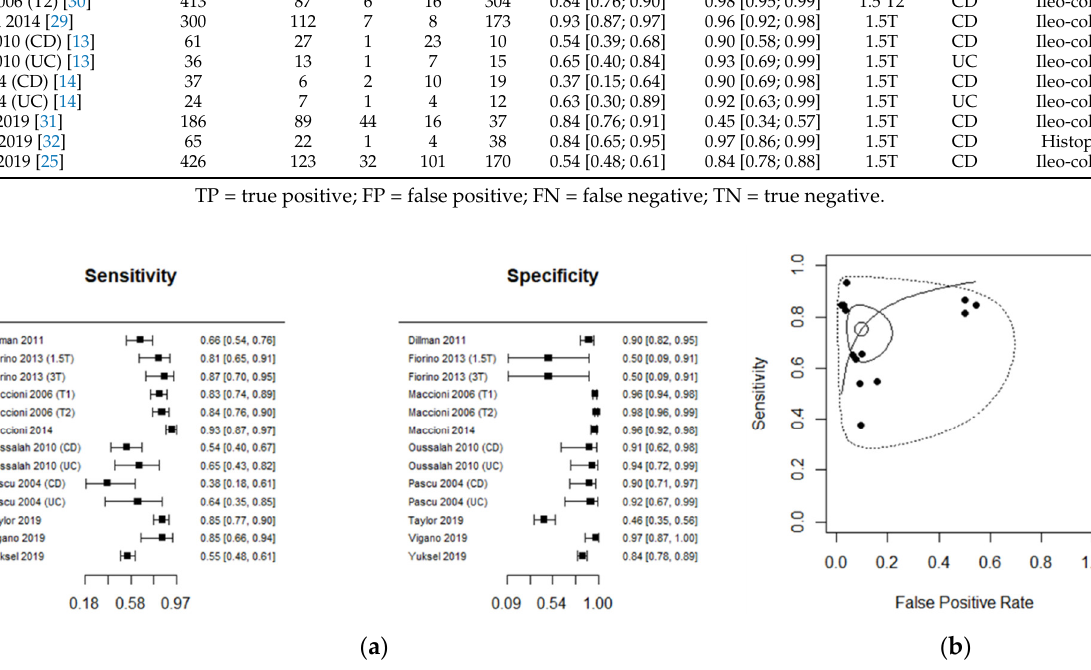
Figure 3. ( a ) Forest plot and ( b ) the summary receiver operating characteristic (ROC) curve illustrating the summary operating point for the diagnostic performance of MRI.